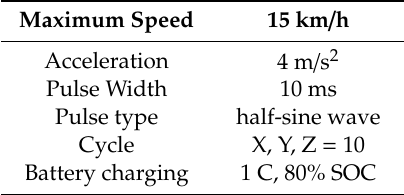
Table 5. Test profile for the impact exerted on the lithium-ion battery while driving.